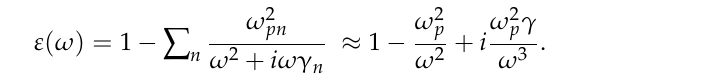
Figure 2. ( a ) Cross-section profile of the electric field norm for a Gaussian beam ( (cid:1865) = 0 ) and Laguerre–Gauss beam